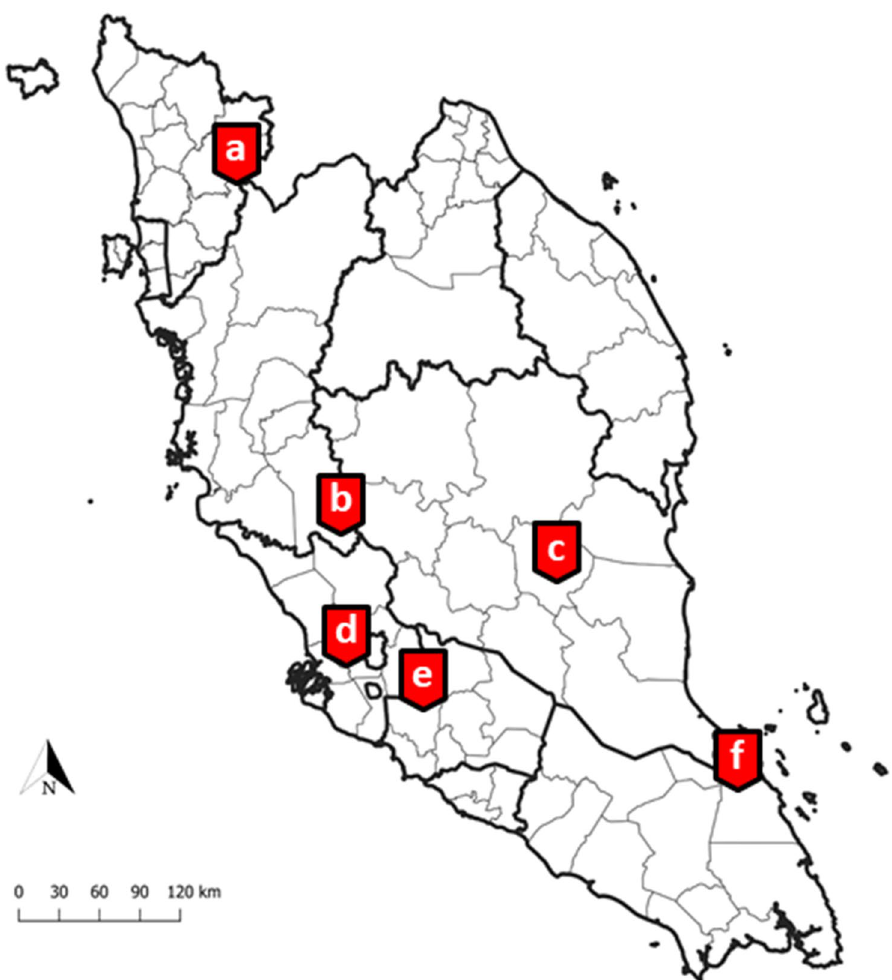
Figure 7. Map of Peninsular Malaysia where the mosquito collections were performed in six different states ( a ) Kampung Kaki Bukit, Baling, Kedah; ( b ) Sungai Dara, Muallim, Perak; ( c ) Kem Sri Gading, Jengka, Pahang, ( d ) Lenggeng forest, Seremban, Negeri Sembilan, ( e ) Community forest reserve, Kota Damansara, Selangor and ( f ) Bukit Tinggi, Mersing, Johor. The map was created using QGIS software version 3.6.3 (https://www.npackd.